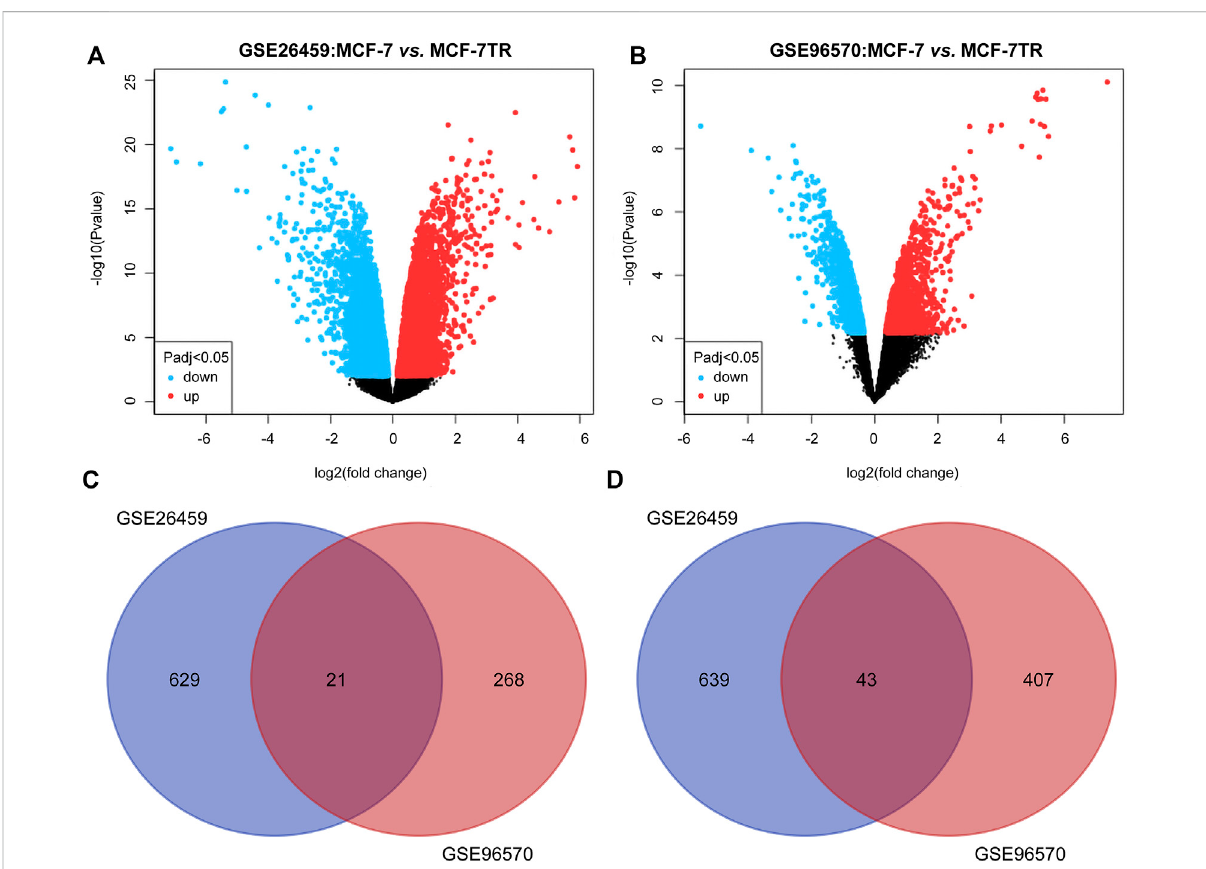
FIGURE 2 DEmRNAs between TMX-resistant and TMX-sensitive breast cancer in two datasets. (A , B) Volcano plots of DEmRNAs in GSE26459 and GSE96570. (C , D) Two datasets intersected by upregulated and downregulated